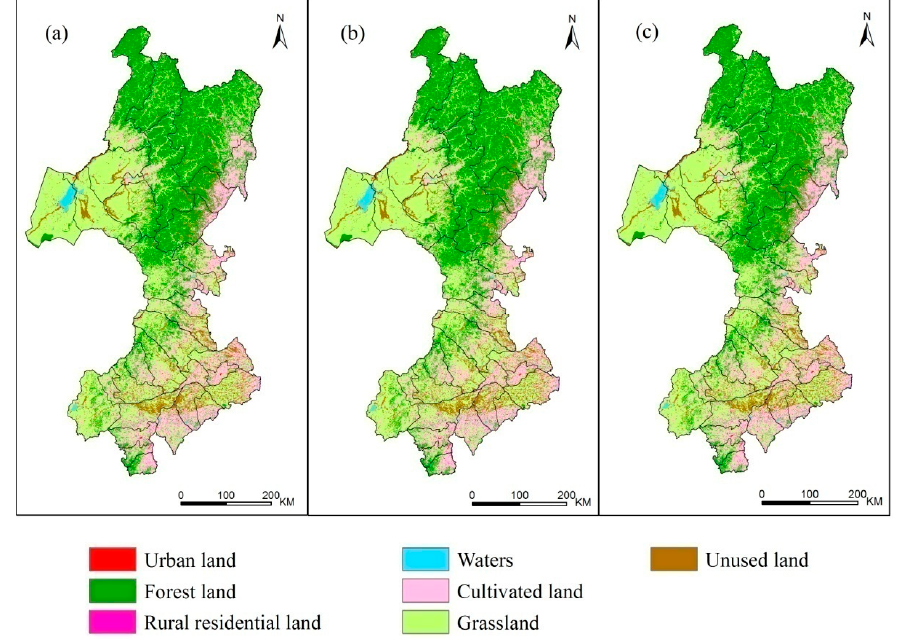
Figure 5. Land use classification results in the study area: ( a ) land use in 2000; ( b ) land use in 2005; ( c ) land use in 2010.